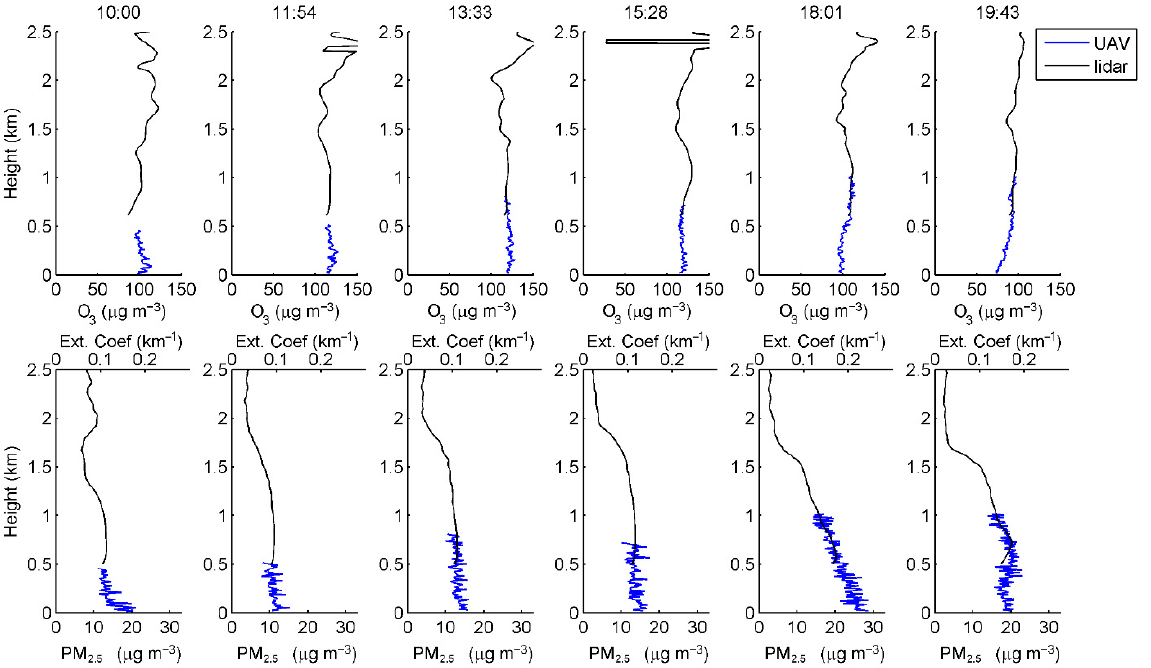
Figure 11. Vertical distribution of ozone concentration, PM 2.5 concentrations, and aerosol extinction coefficient detected by UAV (blue line) and Lidar (black line) on 20 May. The top panel shows the ozone profiles and the bottom panel shows the PM 2.5 and aerosol extinction coefficient profiles.